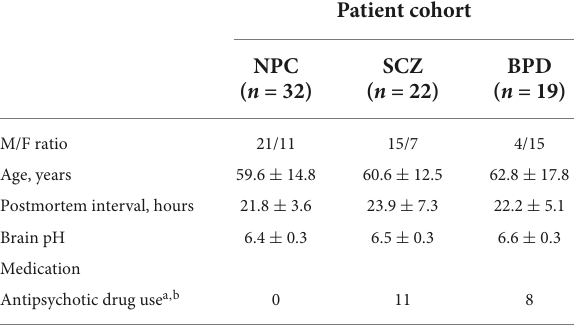
TABLE 1 Subject demographics and clinical